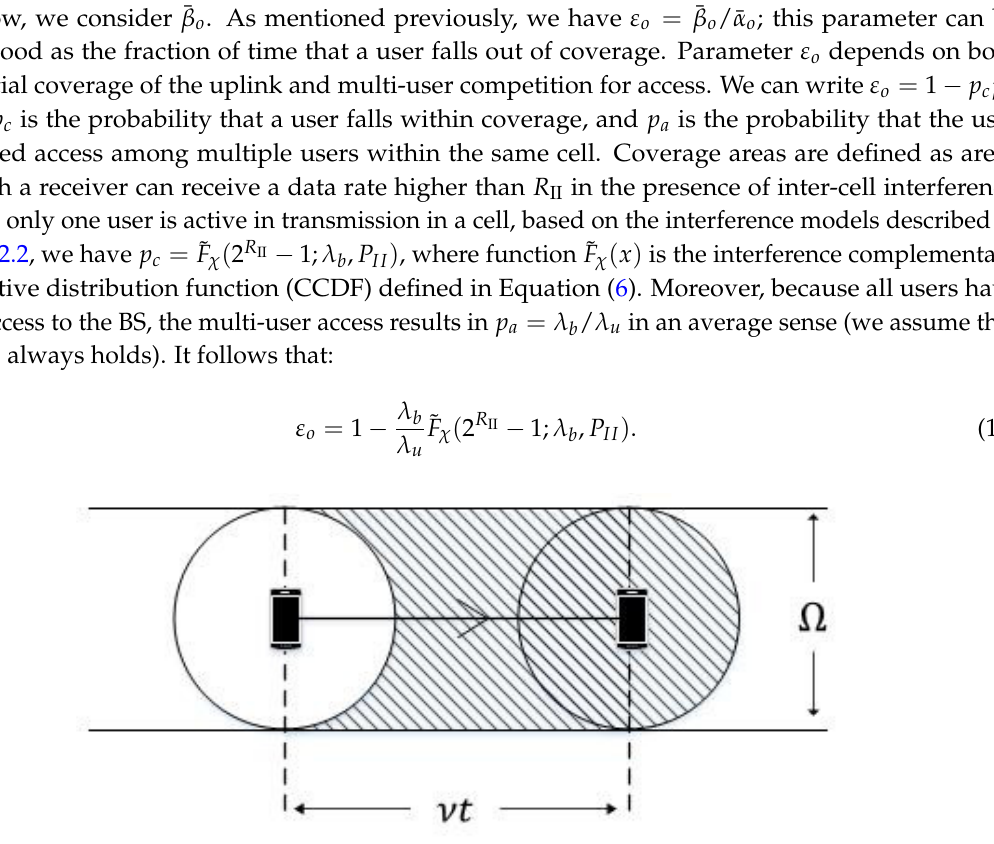
Figure 4. Coverage sensing area of a mobile